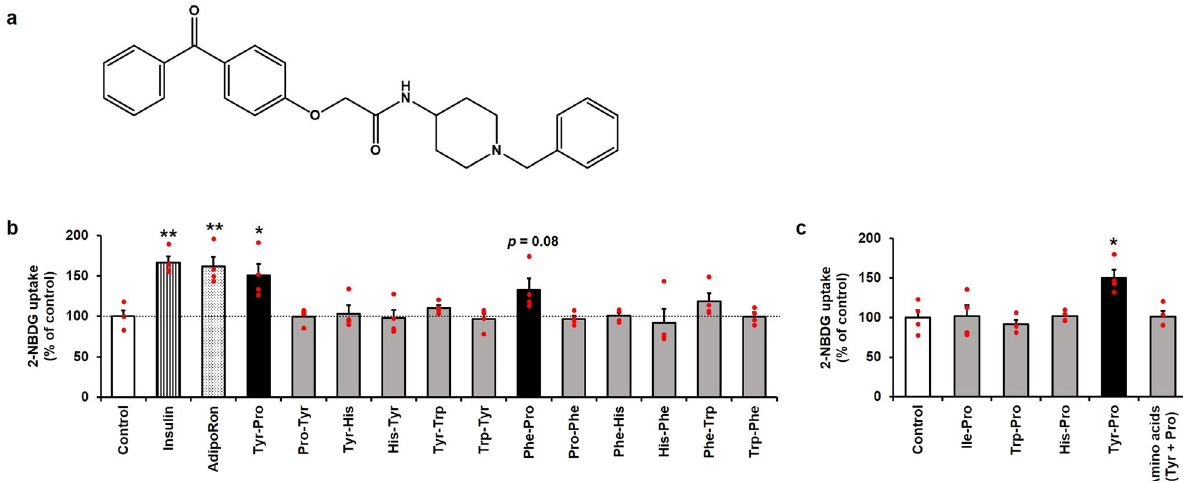
Fig. 1 Screening for dipeptides that promote 2-NBDG uptake in L6 myotubes. a Chemical structure of AdipoRon. b 2-NBDG uptake by 12 dipeptides (Tyr-Pro, Pro-Tyr, Tyr-His, His-Tyr, Tyr-Trp, Trp-Tyr, Phe-Pro, Pro-Phe, Phe-His, His-Phe, Phe-Trp, and Trp-Phe). 2-NBDG uptake experiments of 10 µM dipeptides for 0.5 h in L6 myotubes were performed. Insulin (0.1 µM) and AdipoRon (0.1 µM) were used as positive control. c 2-NBDG uptake by four dipeptides containing Pro at the C-terminus (Ile-Pro, Trp-Pro, His-Pro, and Tyr-Pro). L6 myotubes were incubated with 10 µM dipeptides or a mixture of Tyr and Pro (Tyr + Pro) for 0.5 h. The 2-NBDG incorporated in L6 myotubes was assayed at excitation and emission wavelengths of 465 and 540 nm, respectively. Results are expressed as the mean ± SEM ( n = 4). Statistical differences were evaluated using unpaired two-tailed Student ’ s t -test. * p < 0.05, ** p < 0.01 vs.